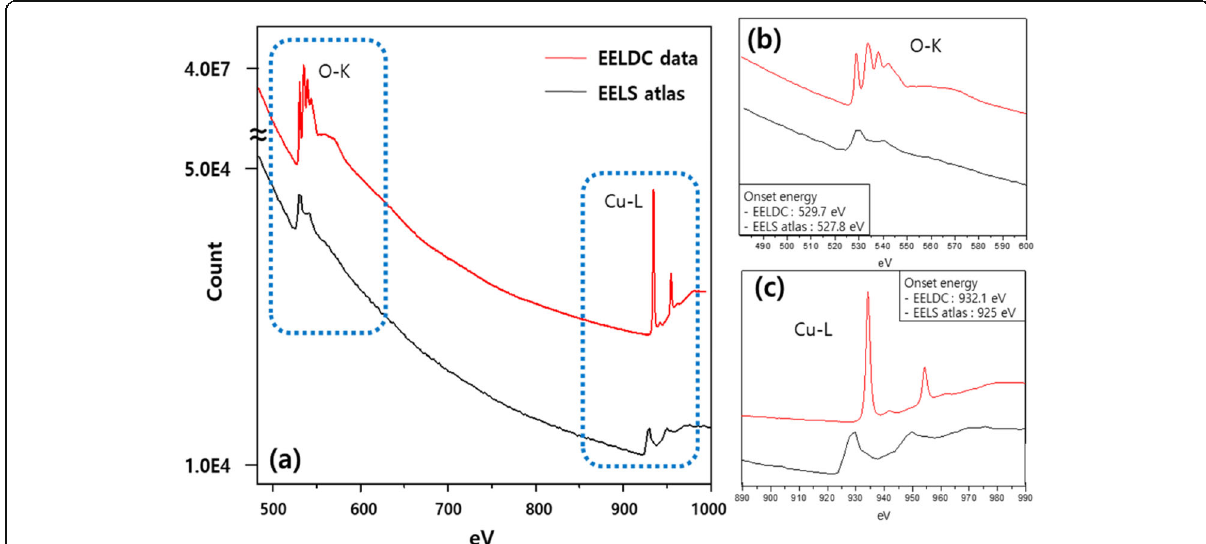
Fig. 2 Comparison of ( a ) existing reference data (EELS Atlas) and the recent standard reference data (EELDC) of CuO. The magnified areas of O-K and Cu-L are shown in ( b ) and ( c ),